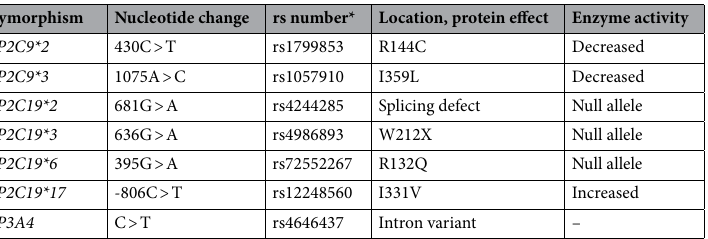
Table 1. Locations and effects of CYP2C9 , CYP2C19 , and CYP3A4 polymorphisms (adopted from 12,13 ).